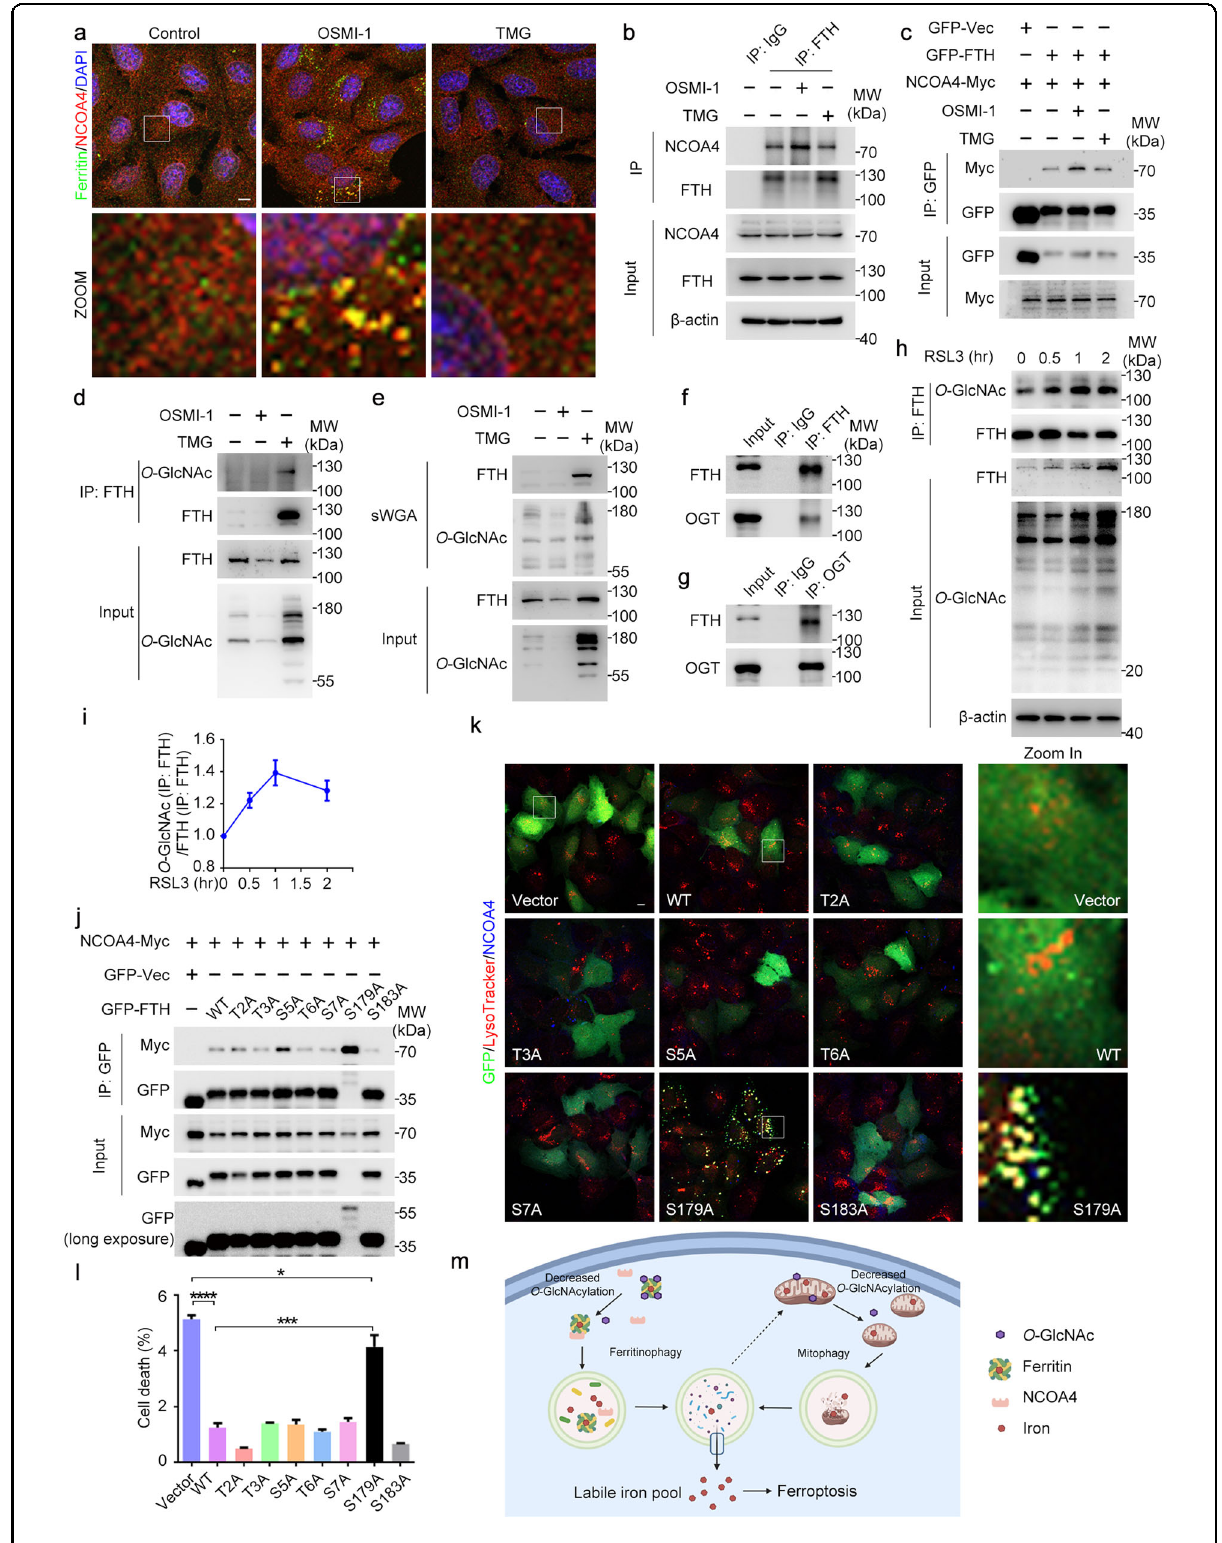
Fig. 6 (See legend on next